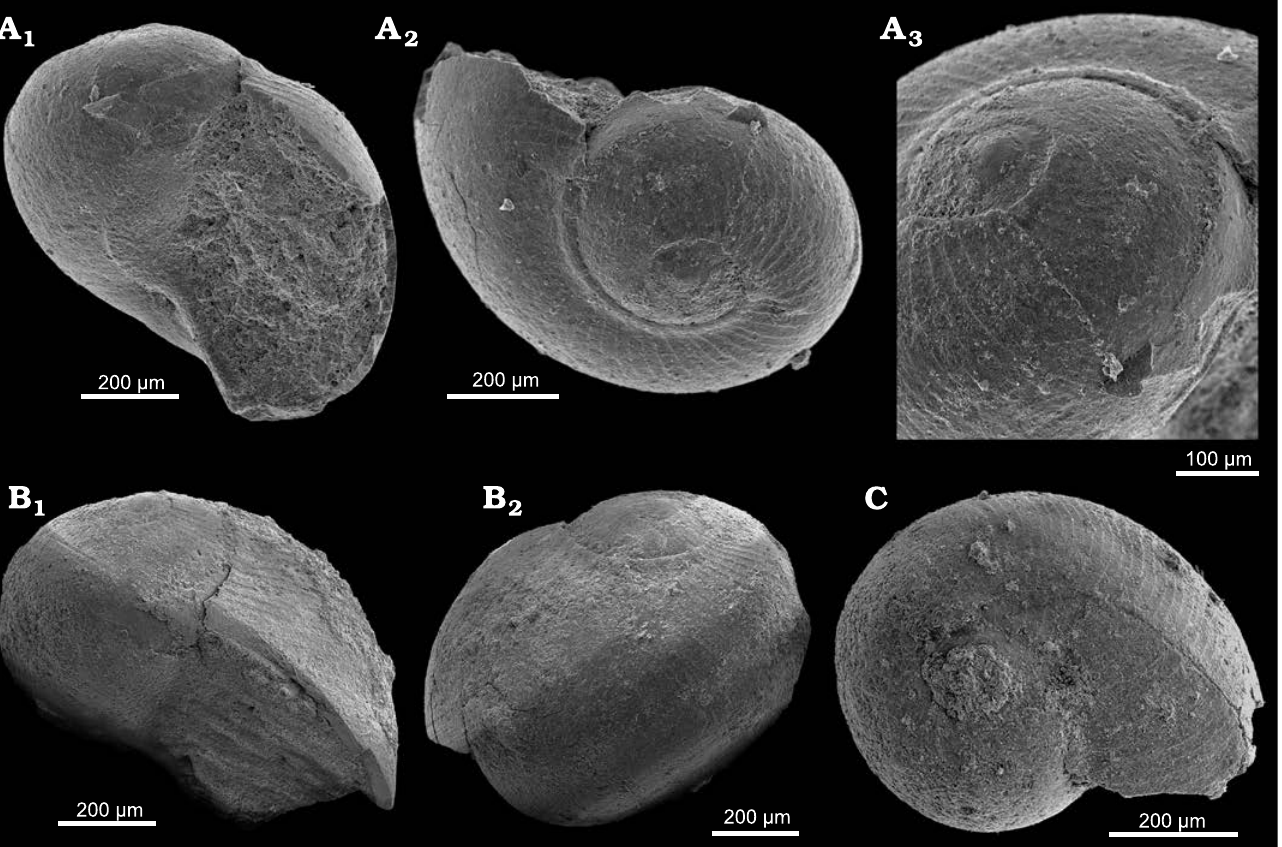
Fig. 9. Neritariid gastropods Dentineritaria neritina (Münster, 1841) from Lago Antorno (A) and Misurina Landslide (B, C), northern Italy, Cassian Formation, Carnian, Upper Triassic. A . PZO 12801, in apertural (A 1 ) and apical (A 2 ) views; A 3 , end of smooth larval shell well visible in oblique lateral view. B . PZO 12683, in apertural (B 1 ) and abapertural (B 2 ) views. C . PZO 12684 in apical